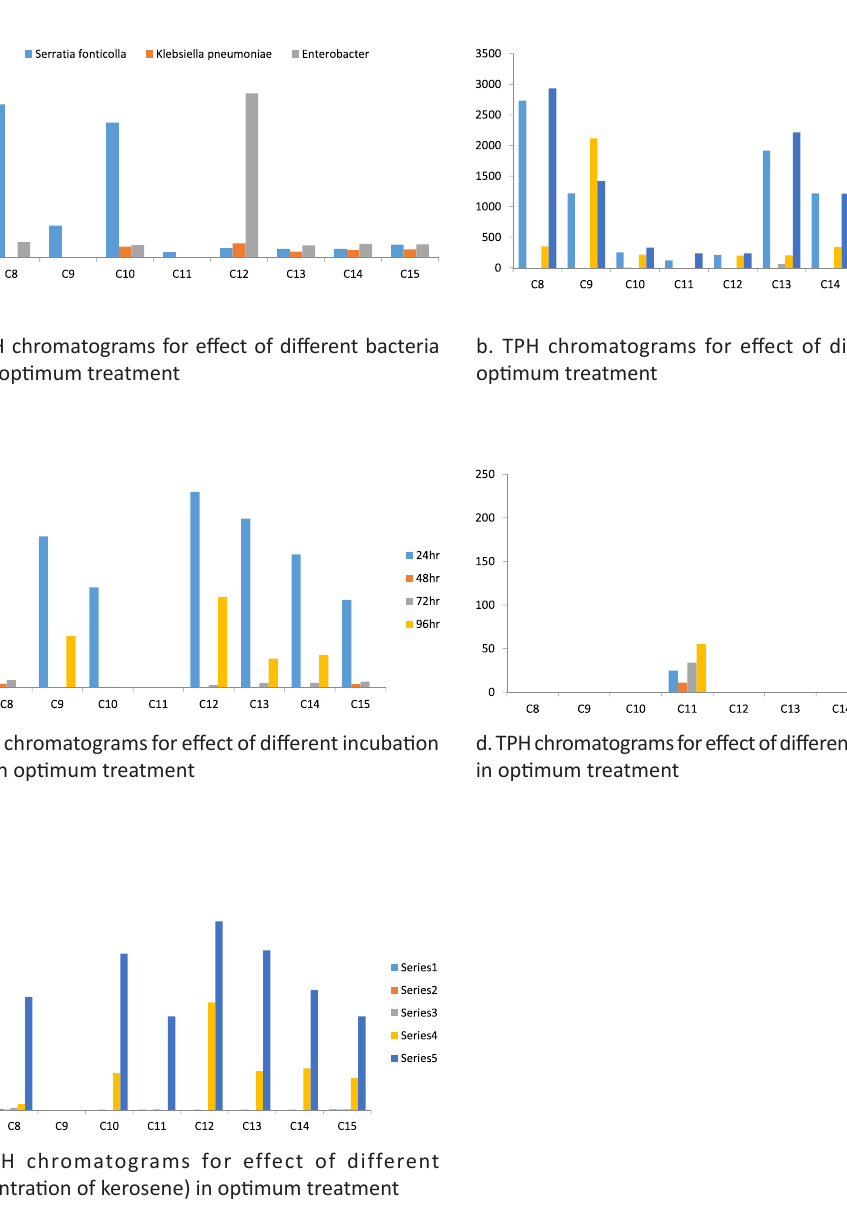
Supplementary Figure 1. Gas chromatography of kerosene degradation